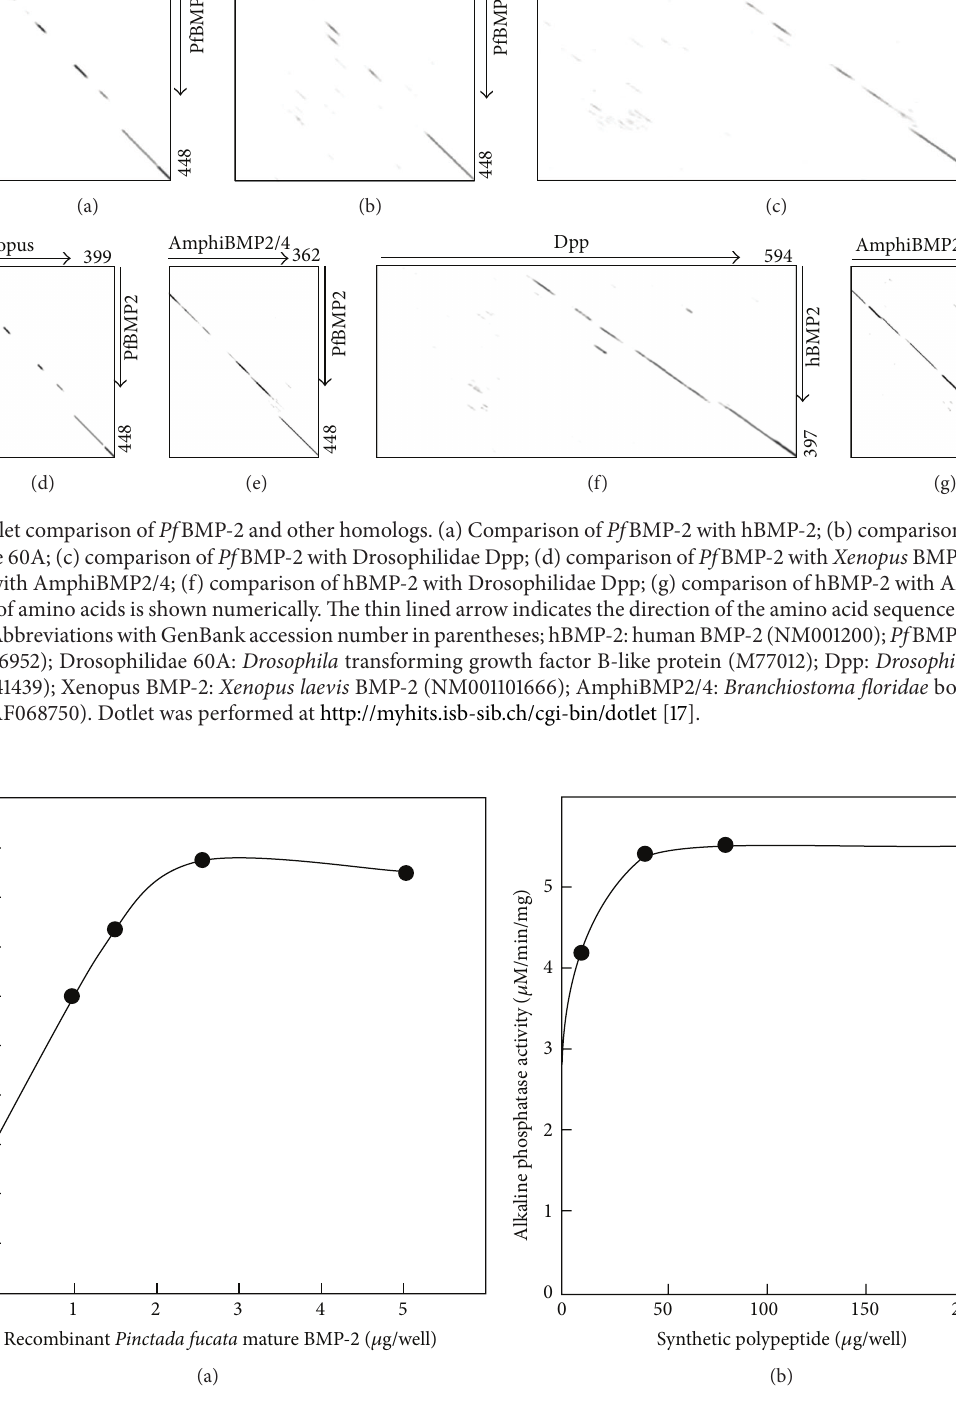
Figure 2: Dose-response effect of BMP-2 on alkaline phosphatase activity. C3H10T1/2 cells were plated into 48-well tissue culture dishes and cultured for 2 days under normal conditions. The cells were then cultured for a further 10 days with the recombinant mature domain of Pf BMP-2 (a) (1.0, 1.5, 2.5, and 5 𝜇 g/well) or the synthetic polypeptide of the knuckle epitope of human BMP-2 (b) (10, 40, 80, and 200 𝜇 g/well). The alkaline phosphatase in each well was then assayed and the results are presented as micromoles of p-nitrophenol (p-NP) produced per minute per milligram of